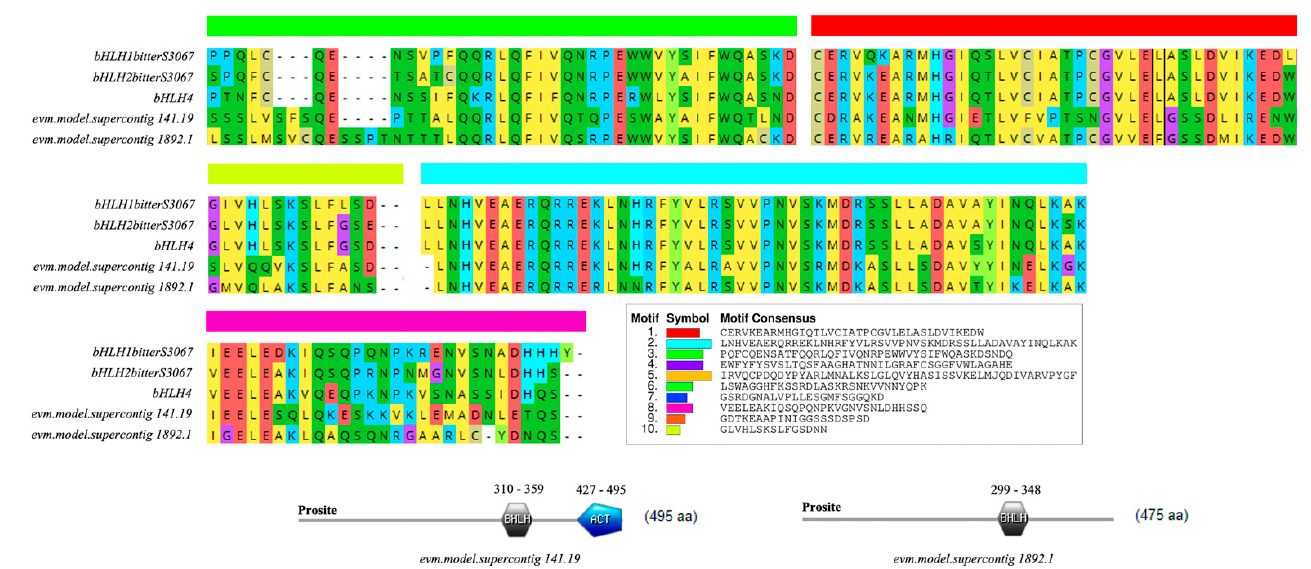
Figure 7. Motif structure of evm.model.supercontig_141.19 and evm.model.supercontig_1892.1 in papaya and bHLH genes in bitter almond ( P. dulcis ). The multiple sequence alignment of these gene sequences highlights the presence of the bHLH domain (Motif 2, coloured in cyan) and several other motifs in the sequences.